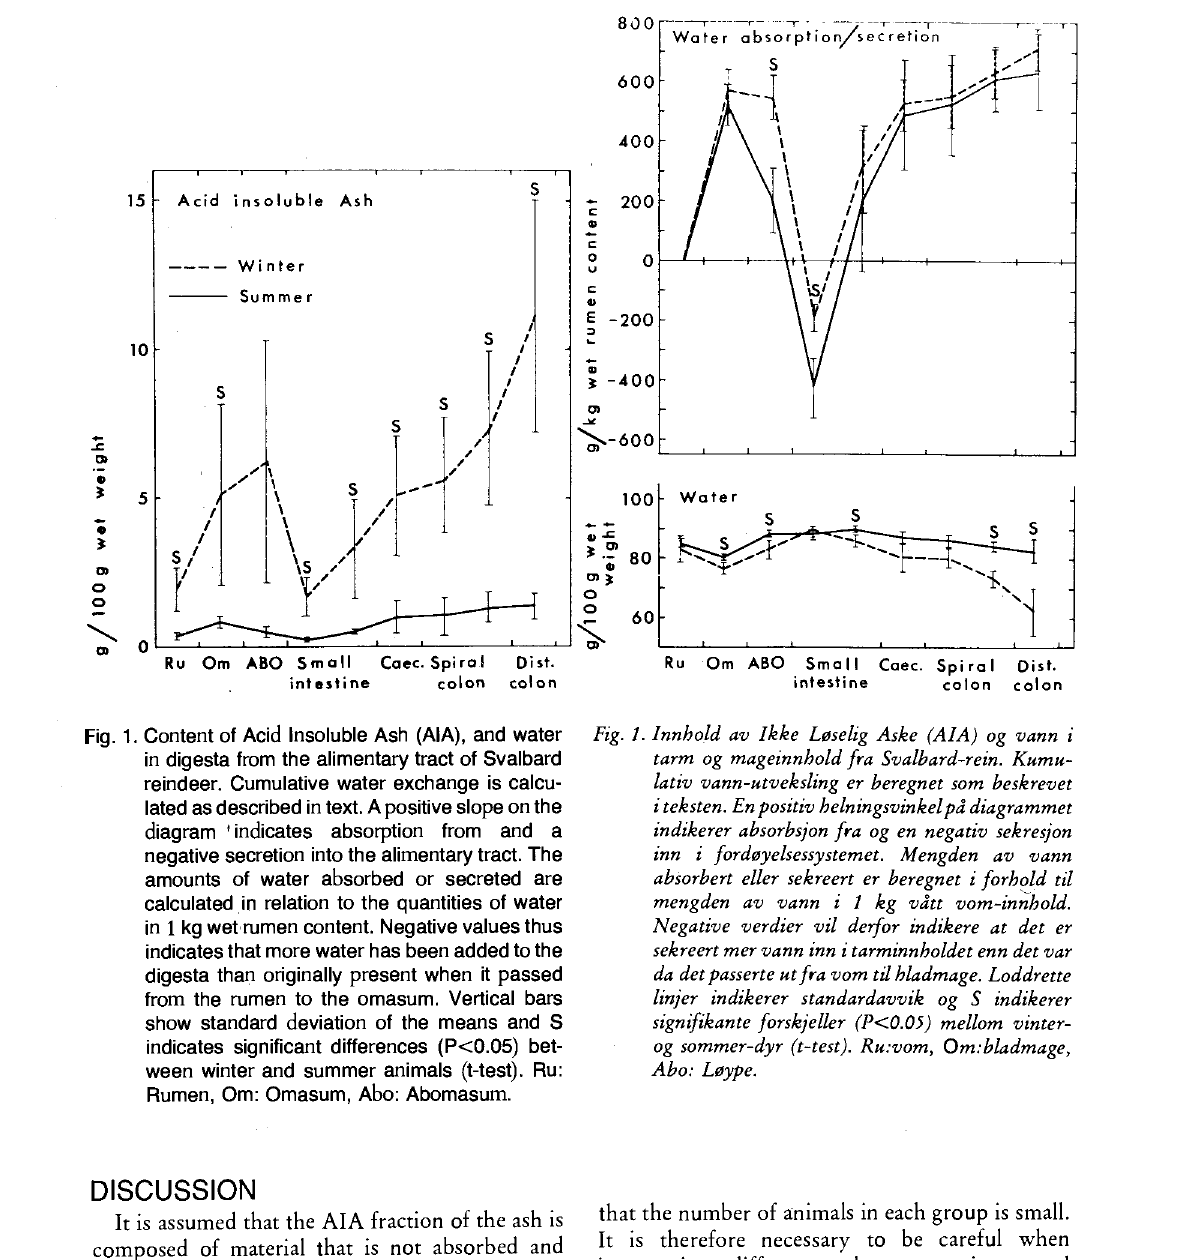
Fig. 1. Content of Acid Insoluble Ash (AIA), and water in digesta from the alimentary tract of Svalbard reindeer. Cumulative water exchange is calcu lated as described in text. A positive slope on the diagram 'indicates absorption from and a negative secretion into the alimentary tract. The amounts of water absorbed or secreted are calculated in relation to the quantities of water in 1 kg wet rumen content. Negative values thus indicates that more water has been added to the digesta than originally present when it passed from the rumen to the omasum. Vertical bars show standard deviation of the means and S indicates significant differences (P<0.05) bet ween winter and summer animals (t-test). Ru: Rumen, Om: Omasum, Abo: Abomasum.